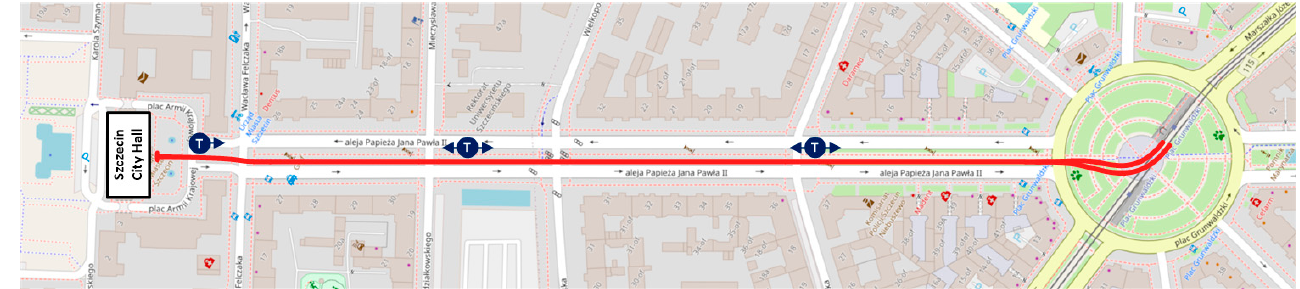
Figure 19. Application of bi-directional trams to operate a single-track tram line running to the Szczecin City Hall (own study based on openstreetmap.org).